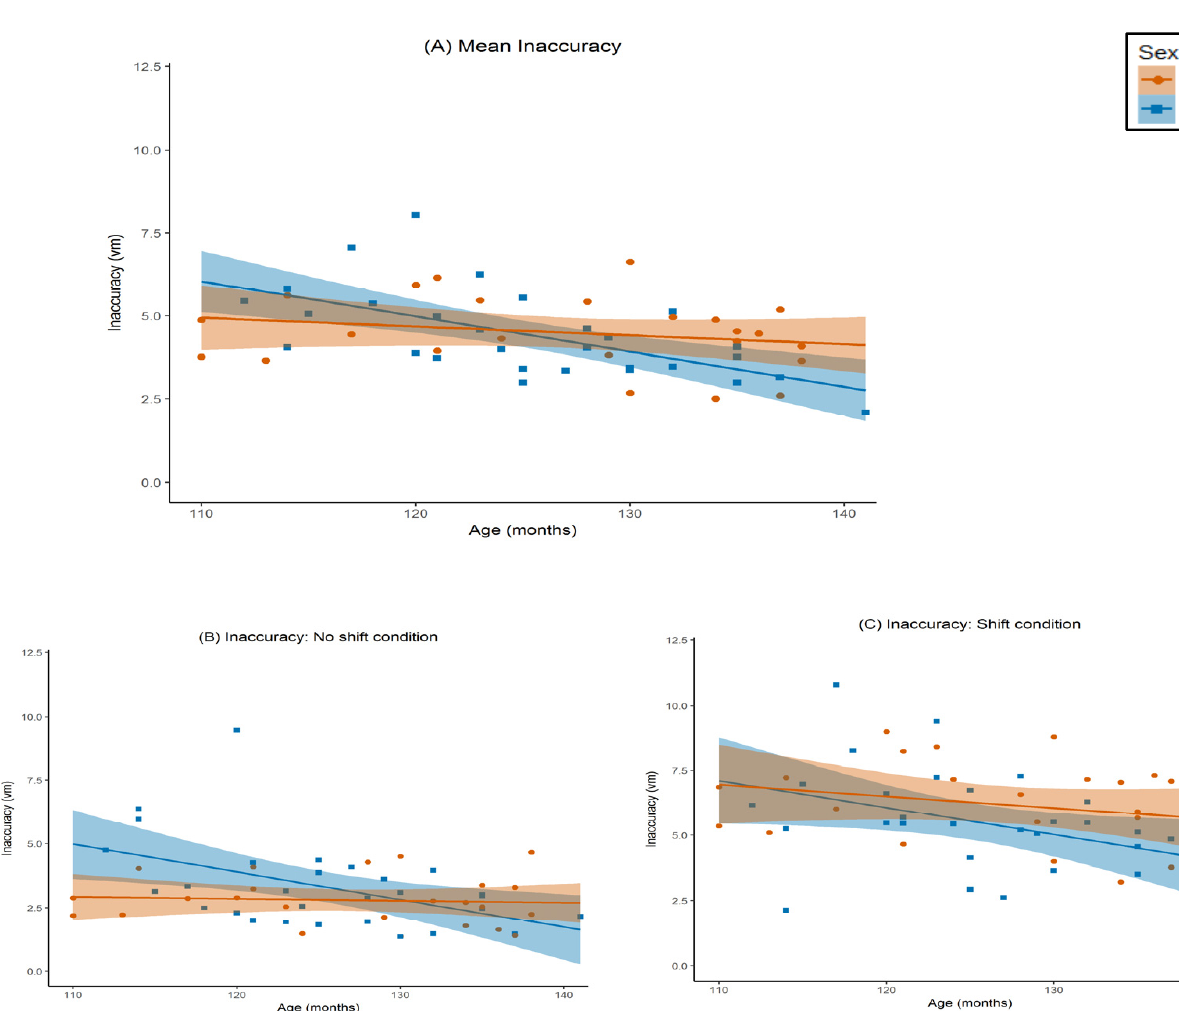
Figure 3. Object distance by age for boys and girls. Object distance was measured as the object distance in virtual meters (vm) between the original location of the object in the encoding phase, and the chosen location by the player in the testing phase. Age was measured in months. The graph is separated by sex: orange circles represent girls, blue squares represent boys. Lines represent the regression line, separated by sex (orange for girls, blue for boys). Shaded area around the regression line represents standard error. ( A ) Mean object distance over both trial types (‘no shift’ and ‘shift’). ( B ) Object distance for the ‘no shift’ condition. ( C ) Object distance for the ‘shift’ condition. The univariate start angle x age interaction effect was not significant for object